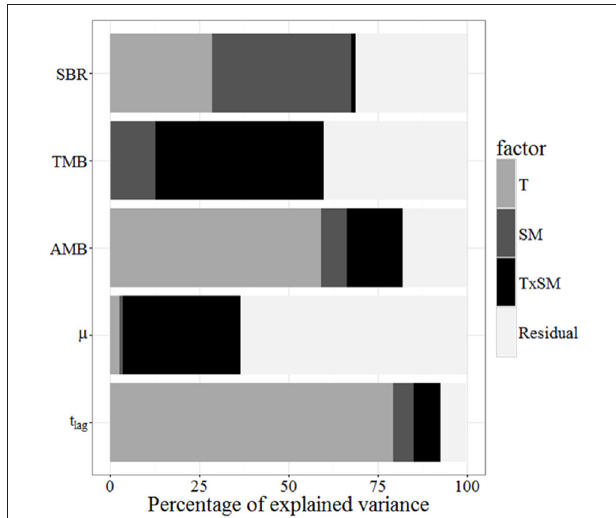
FIGURE 6 | Contributions of temperature, soil moisture, and their interactions to the variance of soil basal respiration, total microbial biomass, active microbial biomass, µ , and t lag , measured as described in Section Statistical Analysis and Curve Fitting. T, Temperature; SM, Soil